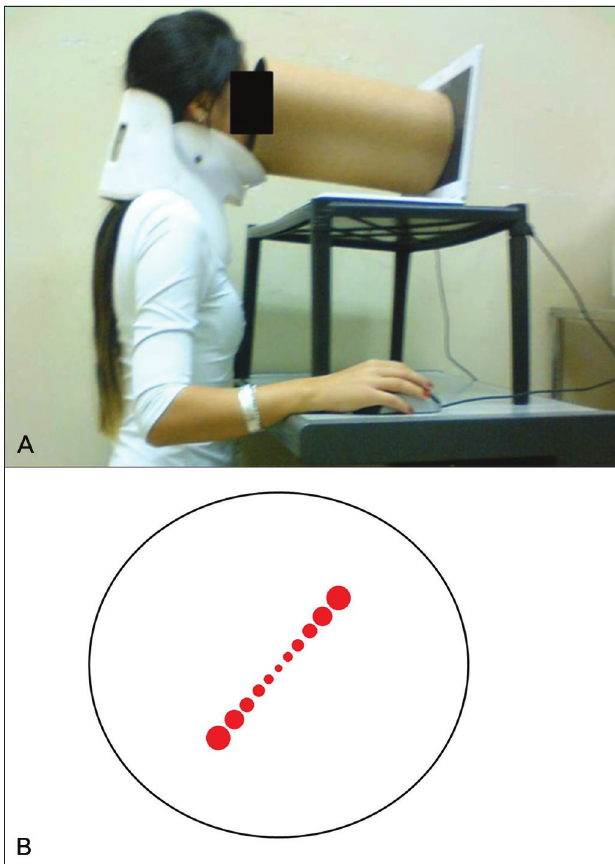
Figura 3. A: Exame de VVS é executado na posição demonstrada. B: Tubo escuro conectado ao monitor para permitir que o exame seja conduzido sem referências